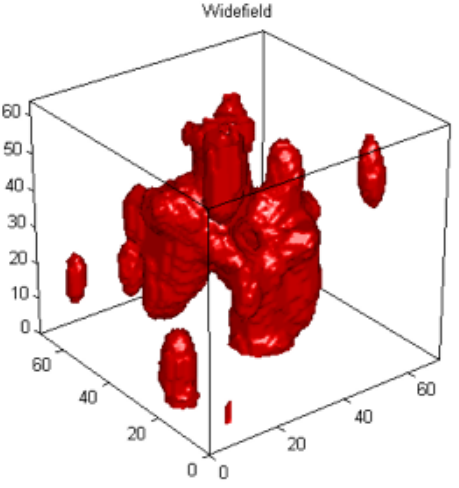
Figure 2. 3D telomere analysis in the Hodgkin cell line HDLM-2. 3D superresolution imaging (3D-SIM) at a resolution up to 50nm dissects large aggregates into clusters of “t-stumps” and few small aggregates. Conventional microscopy (left) identifies one large central aggregate and three telomeres. 3D-SIM (right) dissects the central large aggregate into six telomeres and one smaller